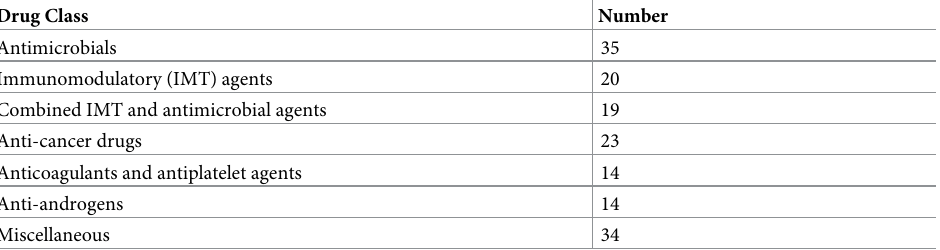
Table 1. Number of drugs studied by